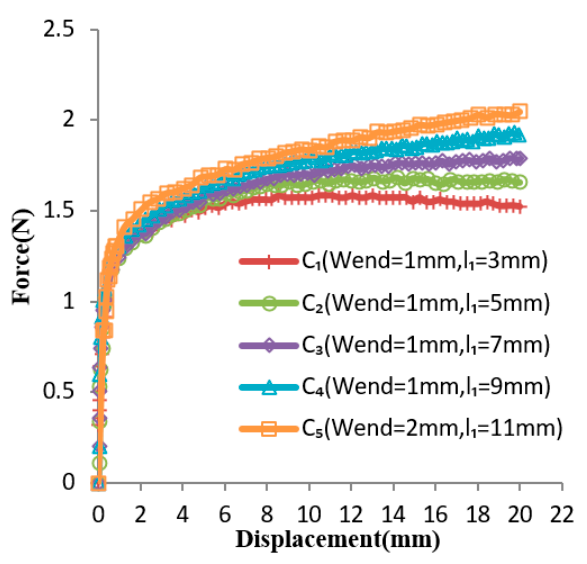
Figure 10. Several experimental curves at changing section widths of the sheet.